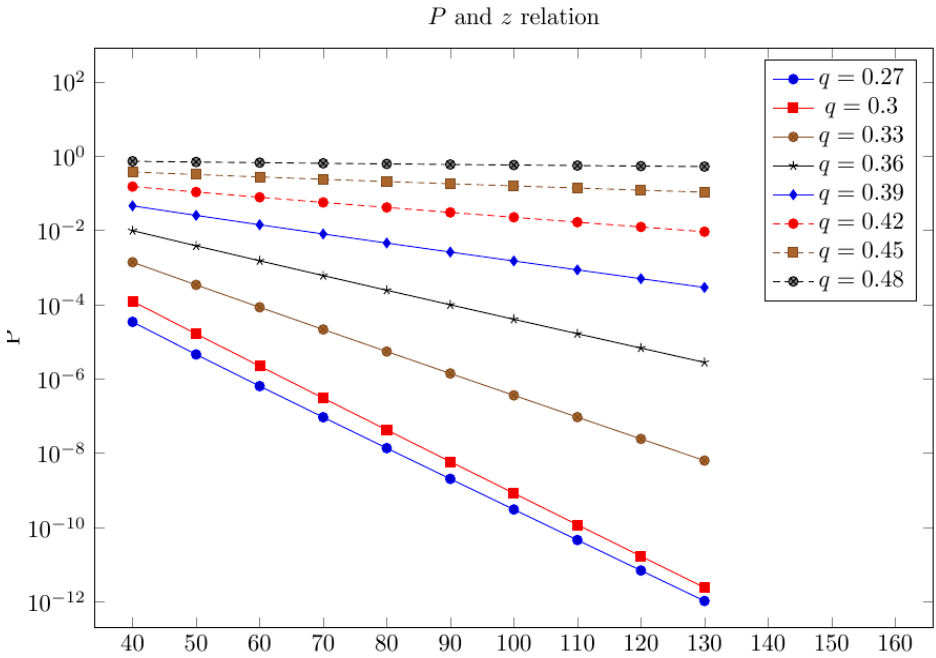
Figure 1. The logarithms of a double ‐ spend attack probability for a different adversary ratio of q .